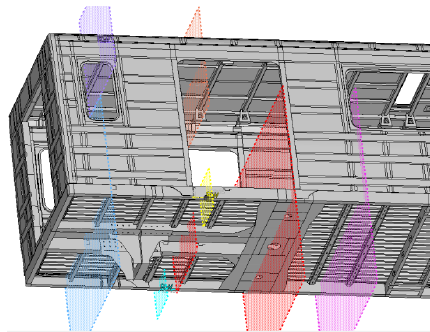
Figure 6. Section force-sensing unit position on the car